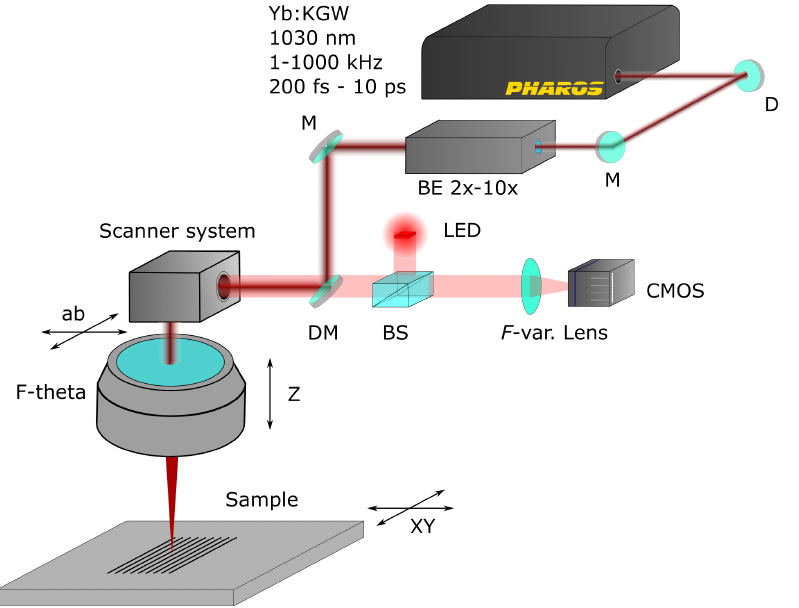
Figure 1. Schematic of subtractive laser workstation. M—mirror, BE—beam expander, BS—beamsplitter, F-var—variable focal distance lens.